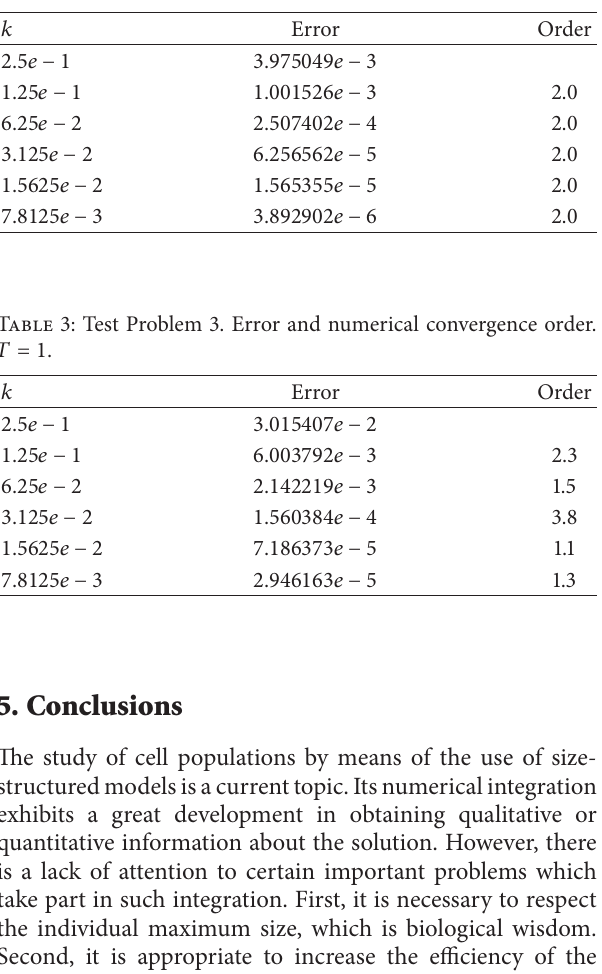
Table 2: Test Problem 2. Error and numerical convergence order. 𝑇 = 1 .